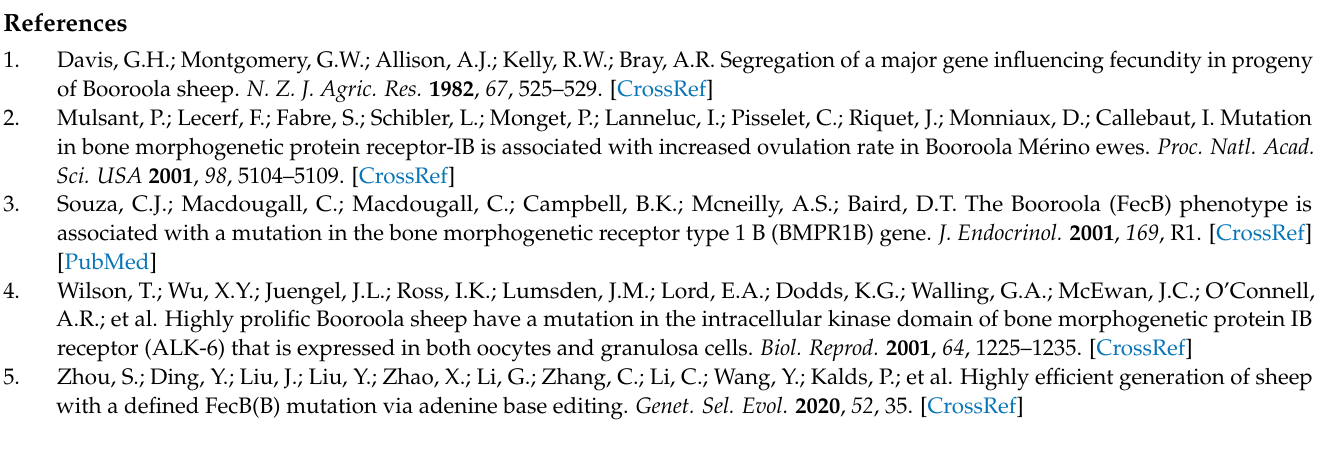
hypothalamus; Figure S2: Illustration of N-integration supervised analysis with DIABLO. Table S1: Search parameters used for protein identification; Table S2: A list of the identified proteins in hy- pothalamus; Table S3: The quantification results of PRM assay of selected proteins in different groups; Table S4: The results of differential proteins abundance in FvsLWW group; Table S5: The results of differential proteins abundance in FvsLBB group; Table S6: The results of differential proteins abundance in Interaction group; Table S7: DAPs KEGG enrichment analysis in the FvsLWW and FvsLBB groups; Table S8: Enriched GO terms of DAPs in FvsLWW and FvsLBB groups; Table S9: The biomarkers selected by DIABLO framework in the proteome and transcriptome data; Table S10: The matrix of the corrlation between the abundance of protein and the expression of mRNA; Table S11: The results of differentially expressed mRNA in Interaction group; Table S12: KEGG enrichment analysis in the DAPs of interaction group; Table S13: KEGG enrichment analysis in the DEGs of inter- action group; Table S14: KEGG enrichment analysis in the proteins selected by DIABLO; Table S15. KEGG enrichment analysis in the mRNAs selected by